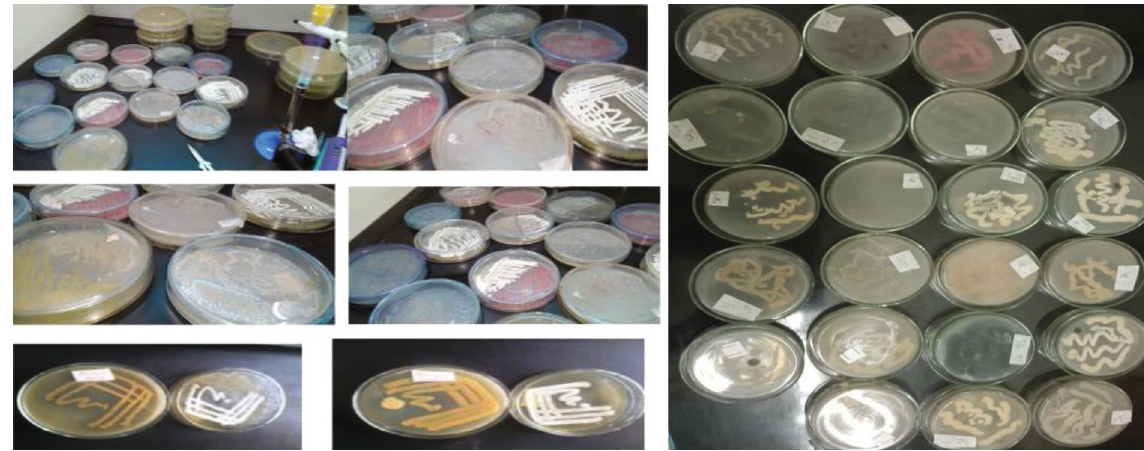
Figure 1: Colony characteristics of broad-spectrum bioactive compound producing Streptomyces isolates. Table 4: Identi fi cation of Streptomyces strains through 16S rRNA gene